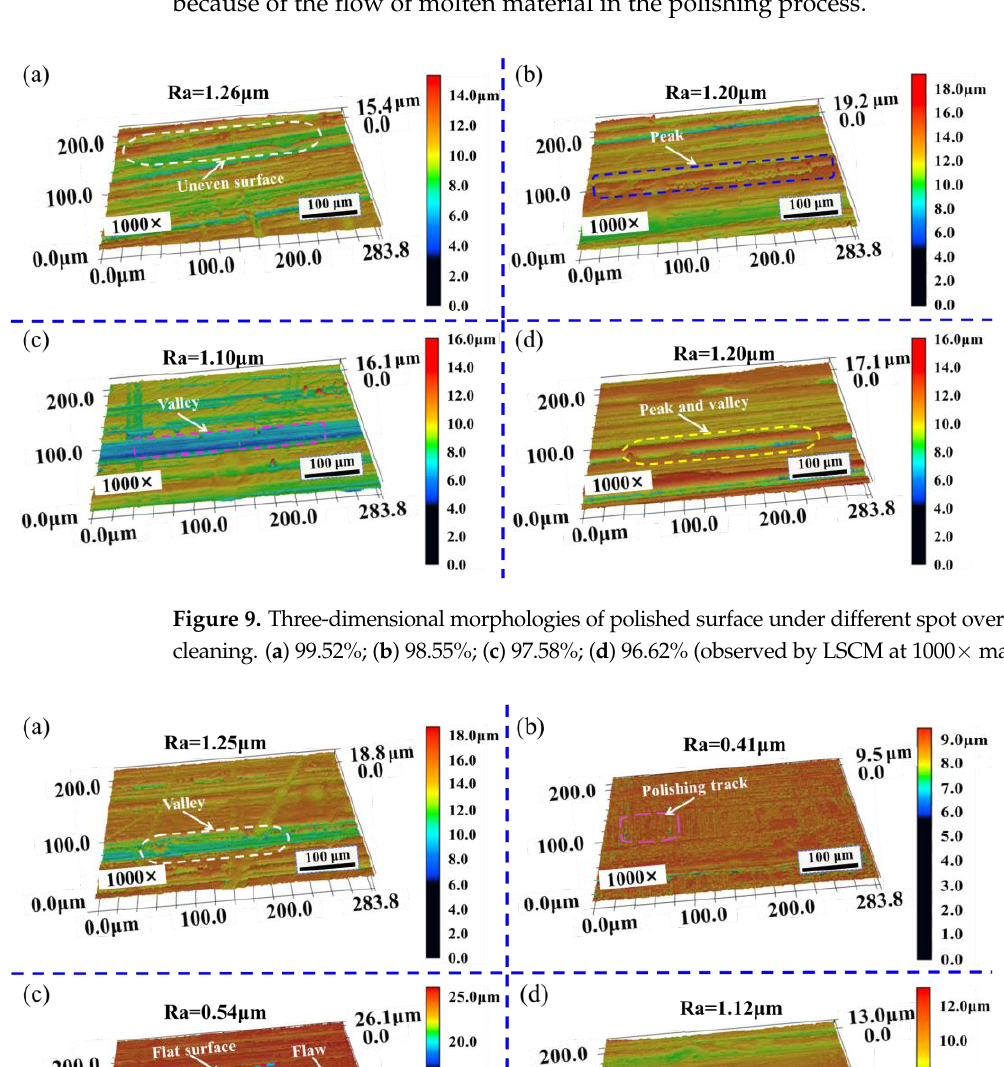
Table 3. The spot overlap ratios of polished mold steel.